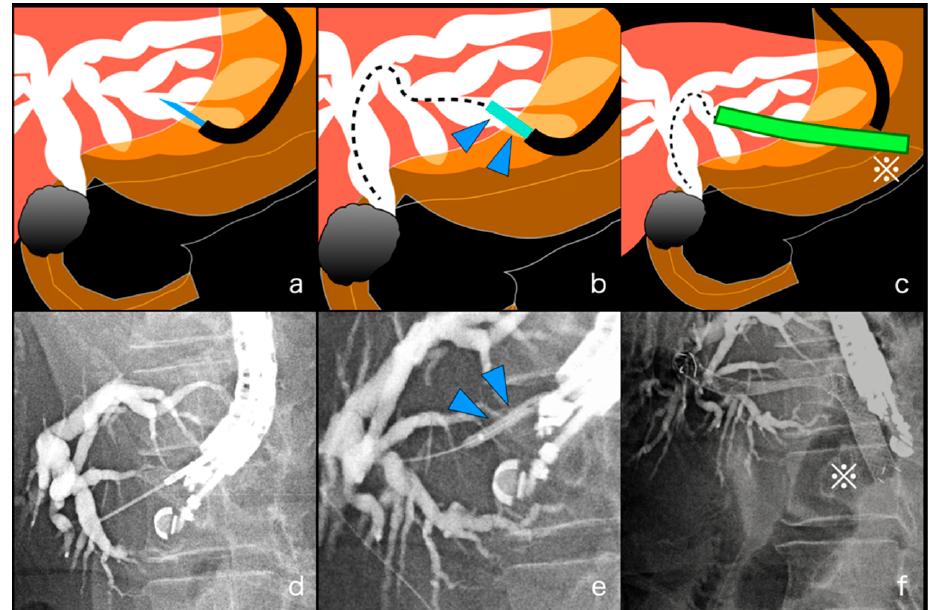
Figure 2. Procedure process of endoscopic ultrasound-guided hepaticogastrostomy (EUS-HGS). ( a , d ). The dilated biliary duct was punctured under EUS guidance using a 19-gauge EUS-guided fine-needle aspiration needle and the contrast medium was injected for cholangiography under fluoroscopy. ( b , e ). The fistula was dilated to 4 mm using a balloon catheter (blue, arrowhead) under fluoroscopy. ( c , f ). Finally, a stent (green, ※ ) was deployed between the dilated bile duct and the stomach or jejunum.